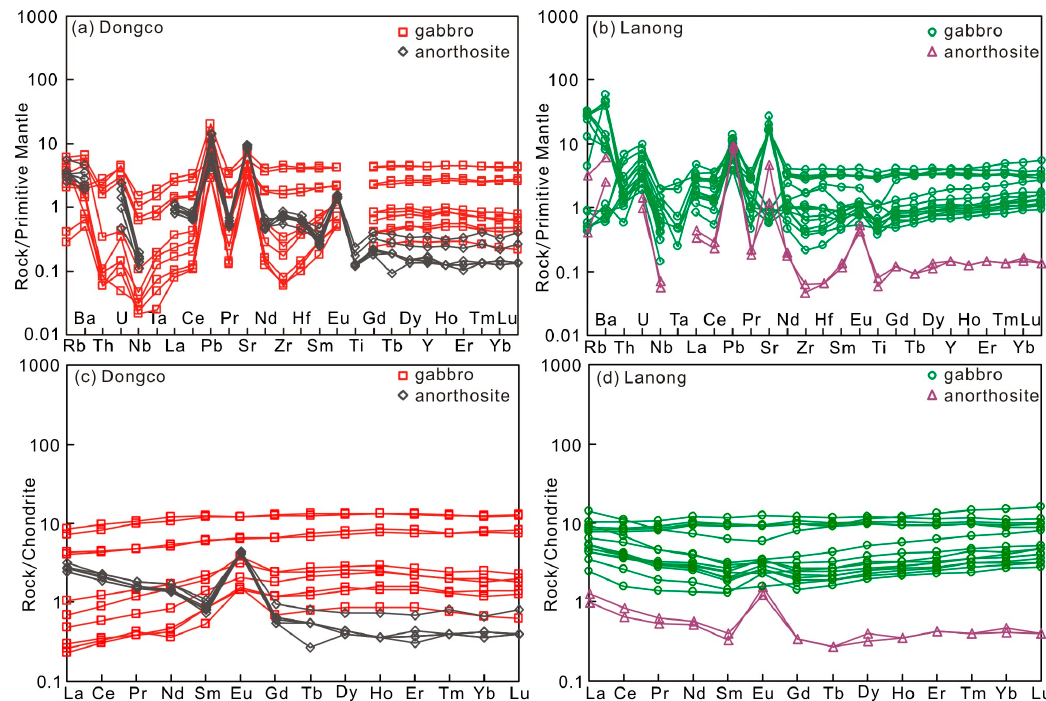
Figure 5. ( a , b ) Primitive mantle (PM)-normalized trace element patterns of gabbros and anorthosites from the Dongco and Lanon ophiolites. ( c , d ) Chondrite-normalized rare earth element (REE) patterns of gabbros and anorthosites from the Dongco and Lanon ophiolites. Twelve of the Dongco gabbro samples are from [27]. Primitive mantle- and chondrite-normalizing values are from